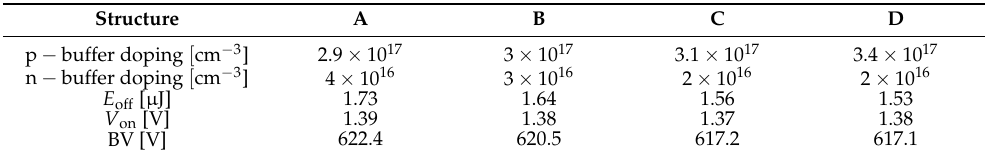
Table 3. Similar structures based on the set